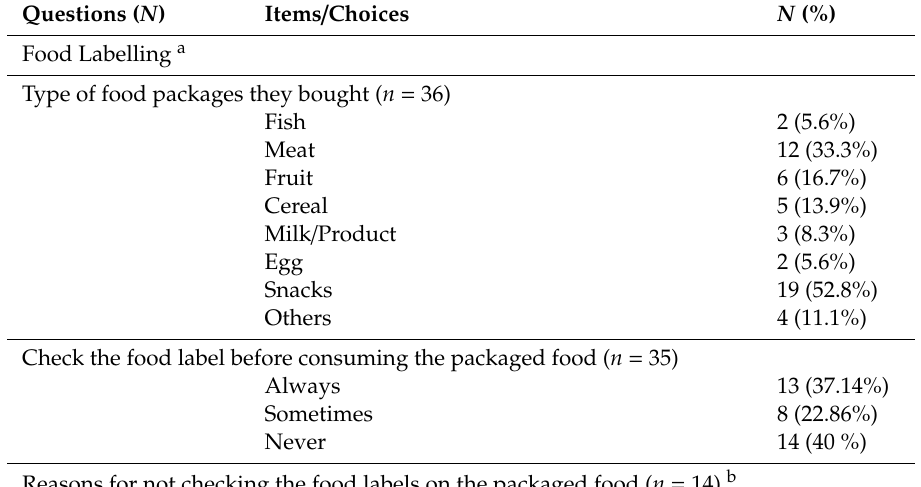
Table 3. Needs assessment results related to food labelling, salt consumption, and food safety problems. Questions ( N ) Items / Choices N (%) Food Labelling a Type of food packages they bought ( n =